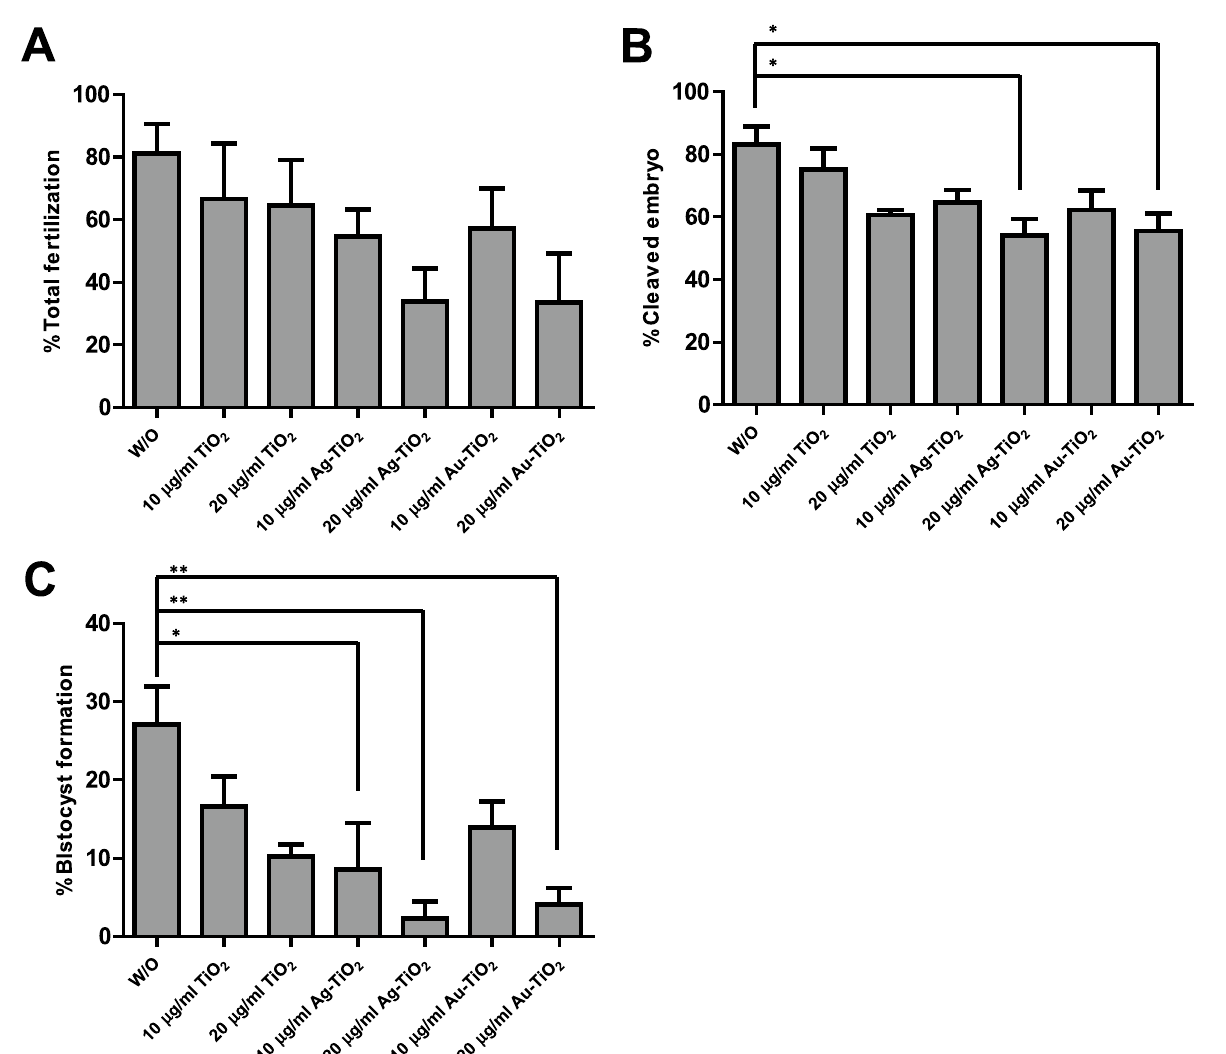
Fig. 6 Fertilization competence of sperm incubated with/without TiO 2 NRs. A Oocytes were fertilized with sperm incubated with control (W/O), Ag‑loaded, and Au‑loaded TiO 2 NRs. B After IVF, fertilized oocytes were cultured for 144 h to observe subsequent embryo development. Numbers of inseminated oocytes are indicated in parentheses. Experiments were independently performed five times. Values are expressed as mean Lines (or dotted lines) among columns denote significant differences at * p < 0.05 and ** p <